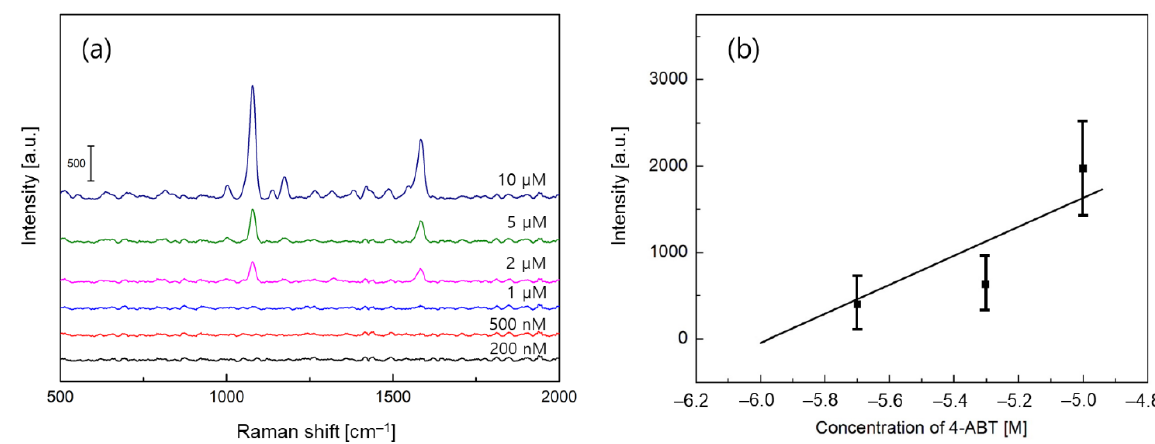
Figure 3. SERS sensor performance measurements. ( a ) SERS experiments of 4-ABT analytes at a varied concentration for a 40 nm thick gold film on a silk substrate. ( b ) Linear regression analysis of the Raman intensities at 1076 cm −1 to quantify the sensitivity and linearity.